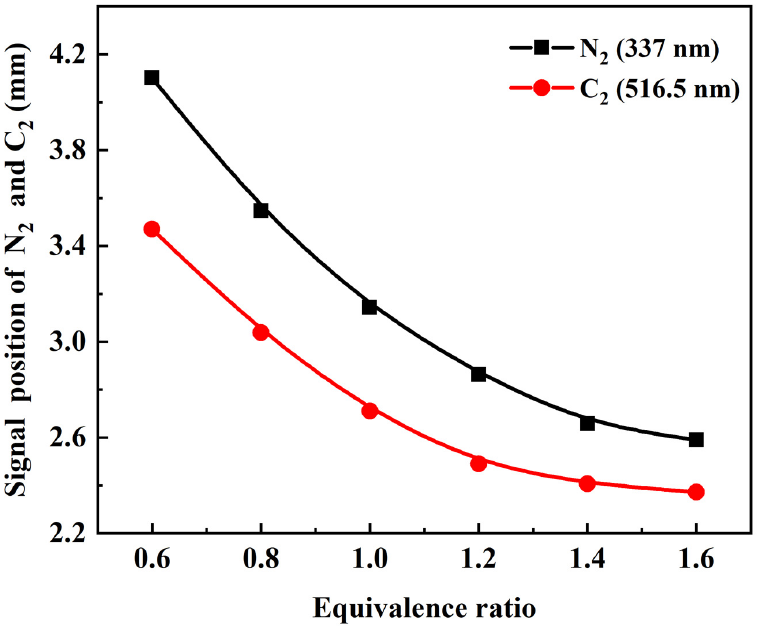
Figure 7. Variation curves of N 2 (337 nm) and C 2 (516.5 nm) signal positions with equivalence ratio.